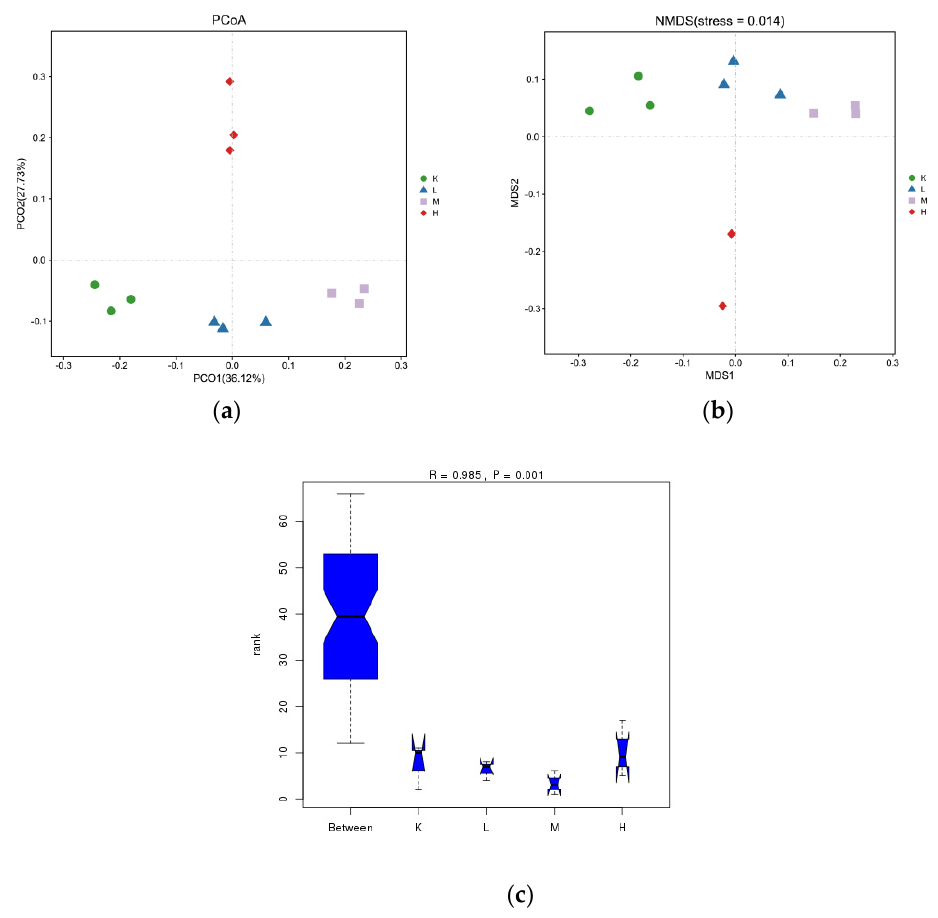
Figure 5. Anthocyanin microbial flora in Opuntia ficus-indica.